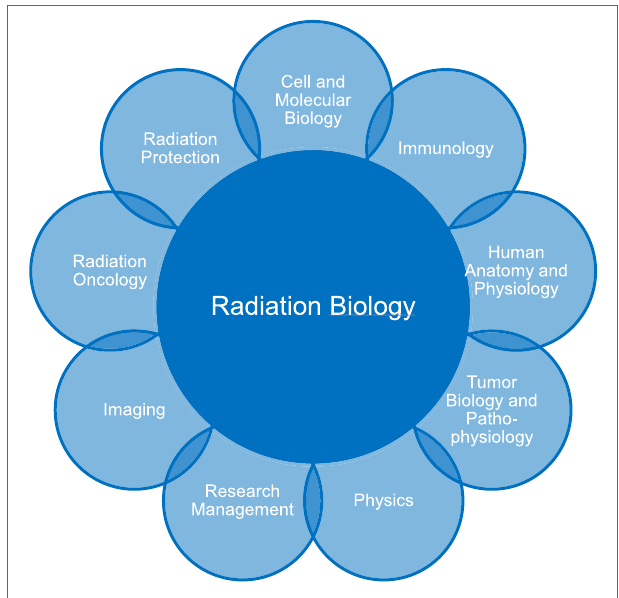
FiGUre 1 | The MSc Radiation Biology was designed as an interdepartmental course including all relevant and related disciplines to the